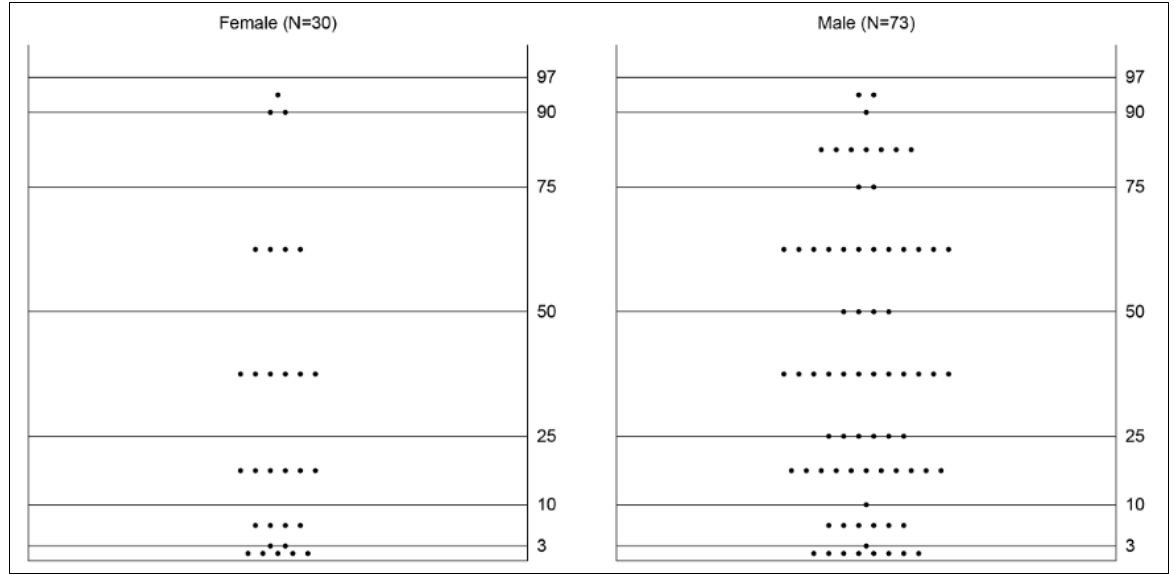
Figure 1: Percentile weight distribution of infants with ARM; all babies with weight less than 10 th percentile con- sidered SGA. (Note that no infants had intrauterine growth retardation).